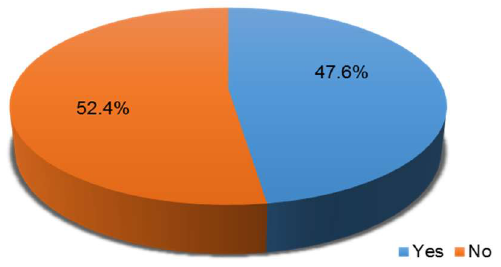
Figure 3. Households that have expanded their agriculture land during the past 15 years ( n = 399).